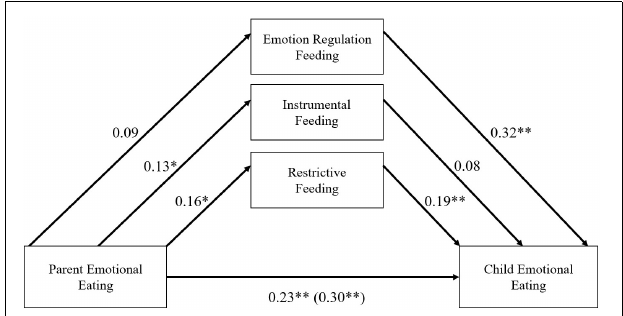
FIGURE 1 | Standardized regression estimates for parallel indirect effects path model with the full sample. * p < 0.05, ** p < 0.001. Covariates included parent stress, parent negative affect, child age, and child gender on all model